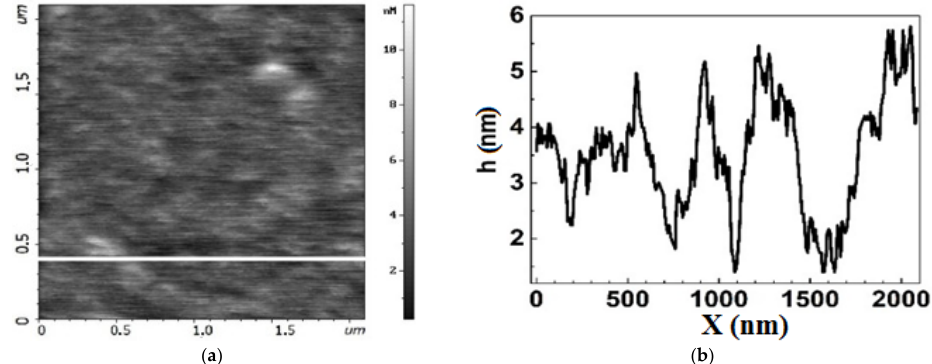
Figure 7. Topography of the graphene surface in chip EG335-5 from Group 1 after the functionalization process. ( a ) AFM image of the surface. ( b ) AFM profile of the graphene surface along the line in ( a ), showing the characteristic nano-arrangement of the surface. Bright areas are equivalent to peaks with large magnitude on the profile curve. Functionalization results in the occurrence of honeycomb-like defects with nano- steps (Figure 8b–d), which are deeper in the chips from Group 2 (Figure 8b). We assume that these changes in the graphene nano-arrangement may lead to an increase in conductivity similar to the case when conductivity increases in the process of porous graphene creation [28]. Moreover, in this work, we used a two-stage functionalization process. The first stage was the formation of covalent bonds during the deposition of nitrophenyl groups. The second stage was the subsequent reduction of the nitrophenyl groups to phenylamine groups by a method of cyclic voltammetry. Details on graphene functionalization can be found elsewhere [20].